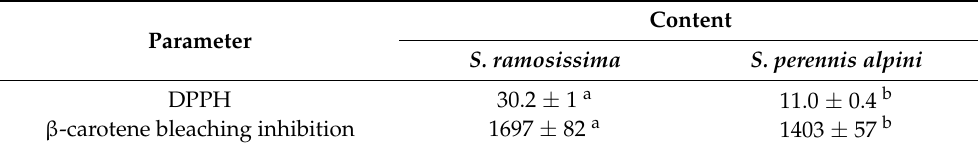
Table 6. Antioxidant capacity of Salicornia ramosissima and Sarcocornia perennis alpini . DPPH radical inhibition assay expressed in mg of trolox equivalents per g of extract dry weight (mg TE/g extract dw) and β -carotene bleaching inhibition test expressed as the antioxidant activity coefficient (AAC) (mean ± SD; n =